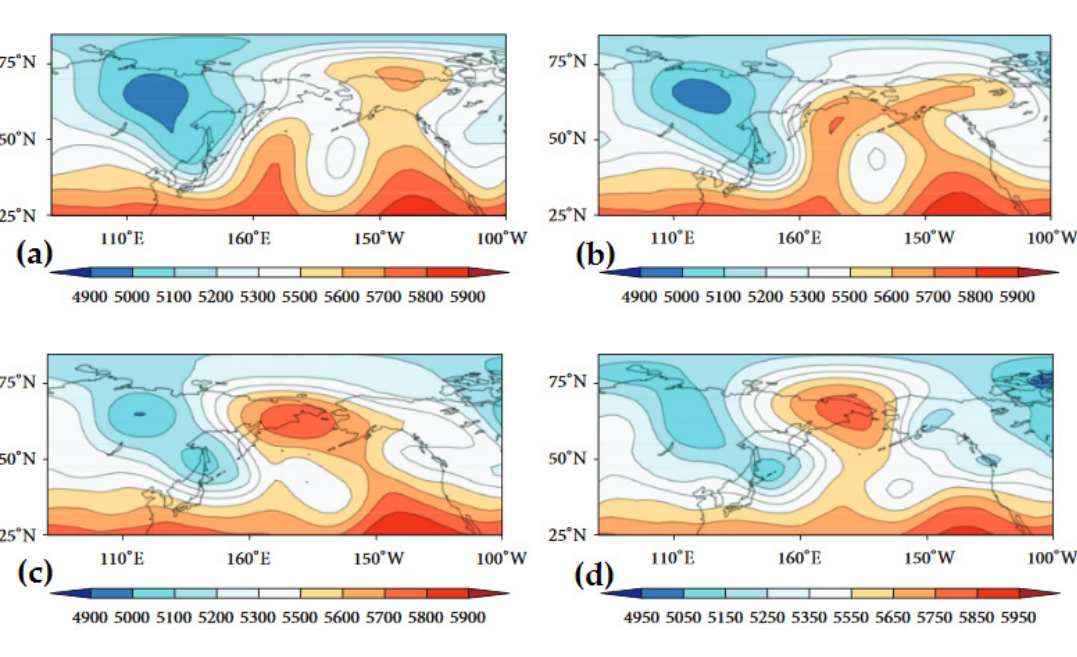
Figure 1. Adapted from [27] the 500 hPa heights derived from the NCEP/NCAR re-analyses over the Pacific Ocean basin at 1200 UTC for ( a ) 4 February; ( b ) 5 February; ( c ) 6 February; and ( d ) 7 February in 2014.